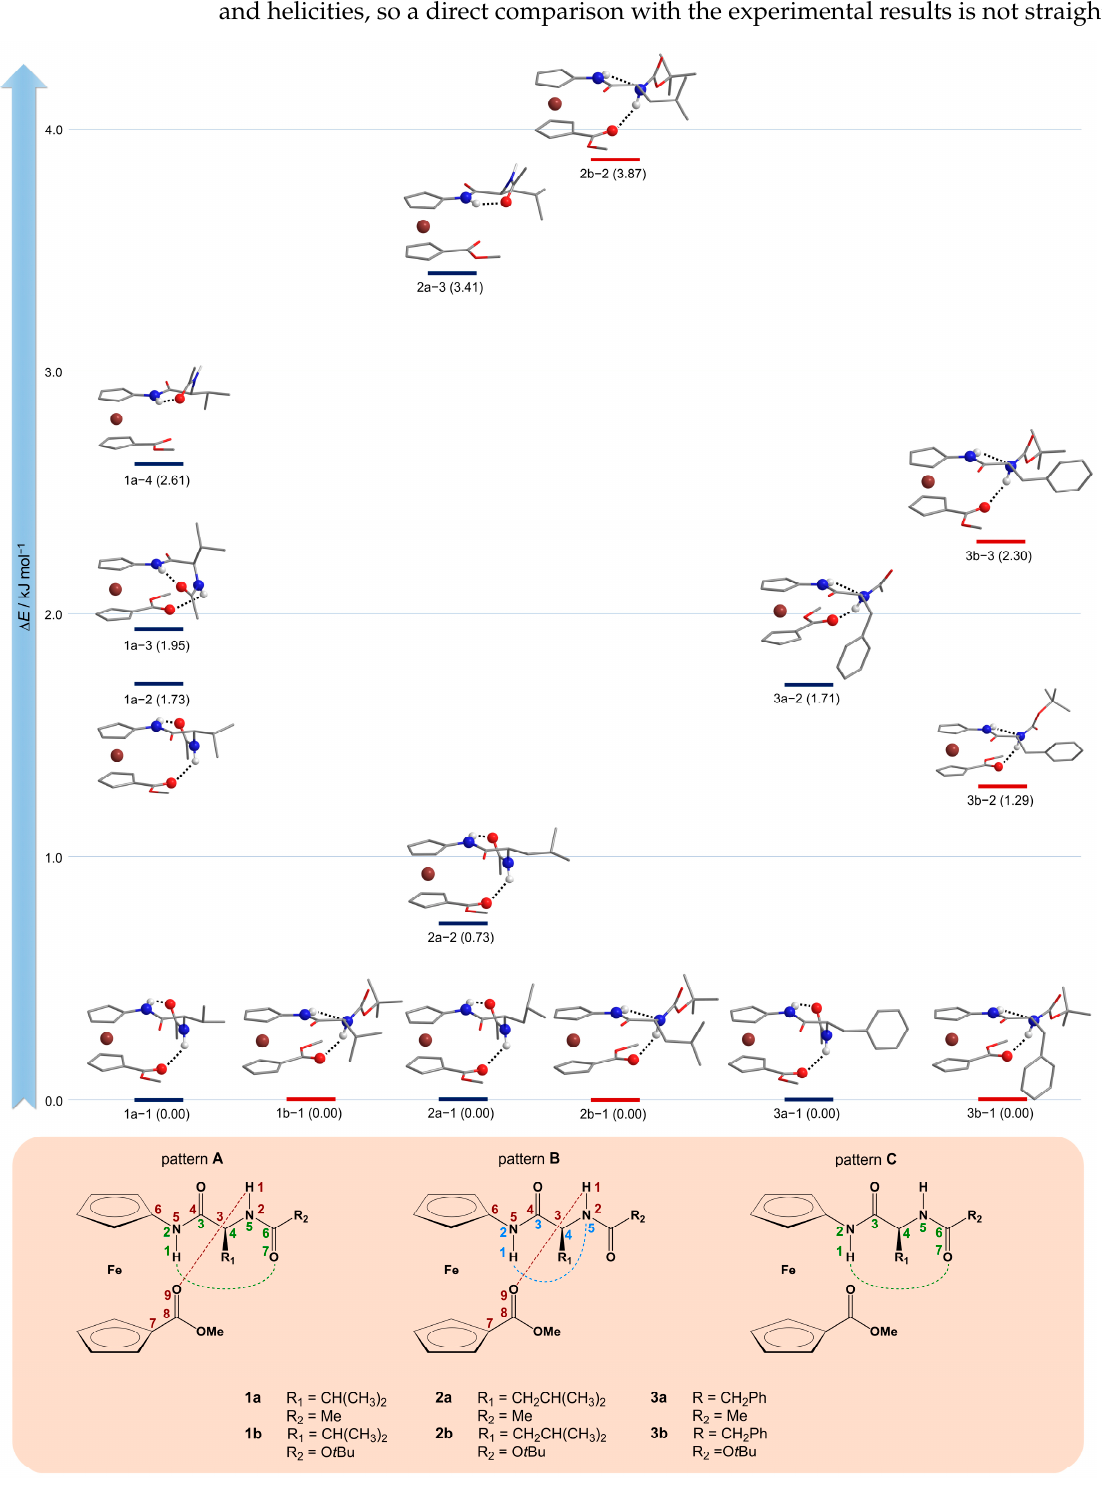
Figure 6. The most stable conformers of D -series of 1a – 3a Ac-protected (blue horizontal lines) and 1b – 3b Boc-protected (red horizontal lines) optimized at the B3LYP-D3/6-311+G(d,p) (LanL2DZ for Fe) level of theory; SMD model used for solvent effect calculations. Nonpolar hydrogen atoms are omitted for clarity. Dashed lines represent hydrogen bonds verified by the QTAIM analysis. Hydrogen-bonding patterns and the numbering schemes of the n -membered hydrogen-bonded rings.